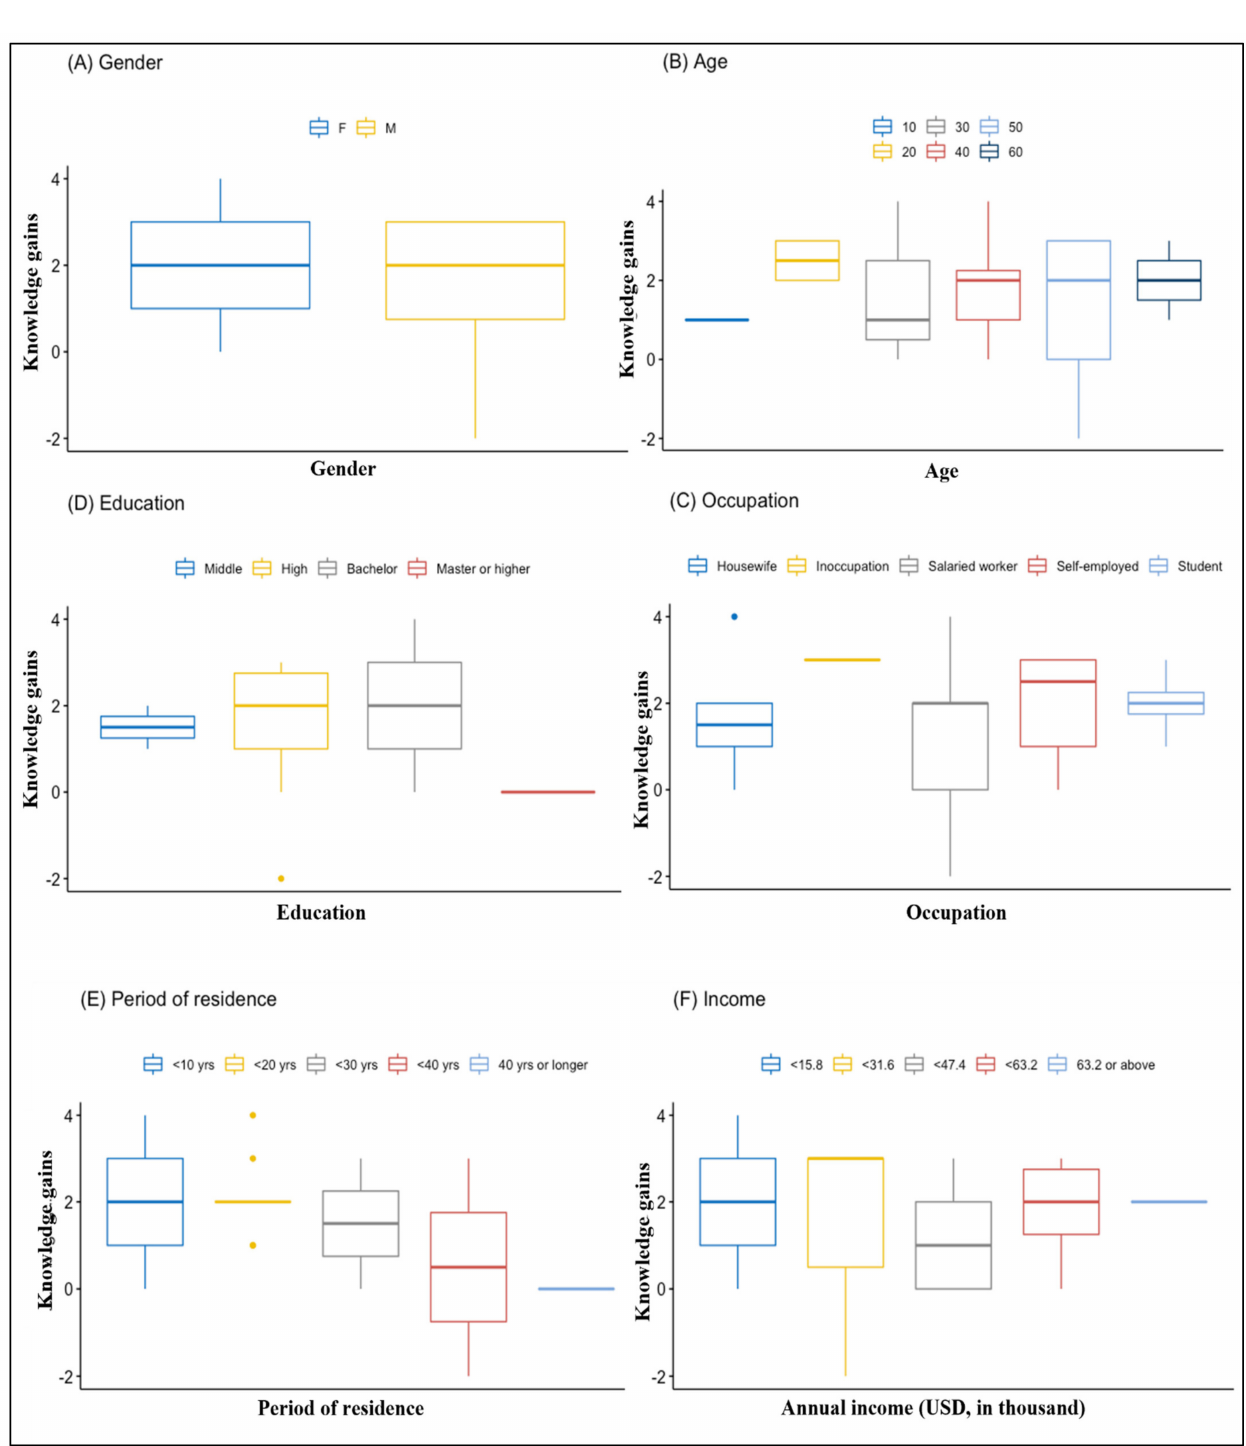
Figure 6. Two-way ANOVA test for socio-economic factors. By comparing the knowledge scores before (mean = 2.33, SD = 1.12) and after (mean = 4.10, SD = 0.76) participation in SLL, we found a significant increase in scores (1.77) from respon- dents through SLL participation ( p < 0.05) (Figure 7). We have statistically significant evidence to show that knowledge has been gained through the living lab